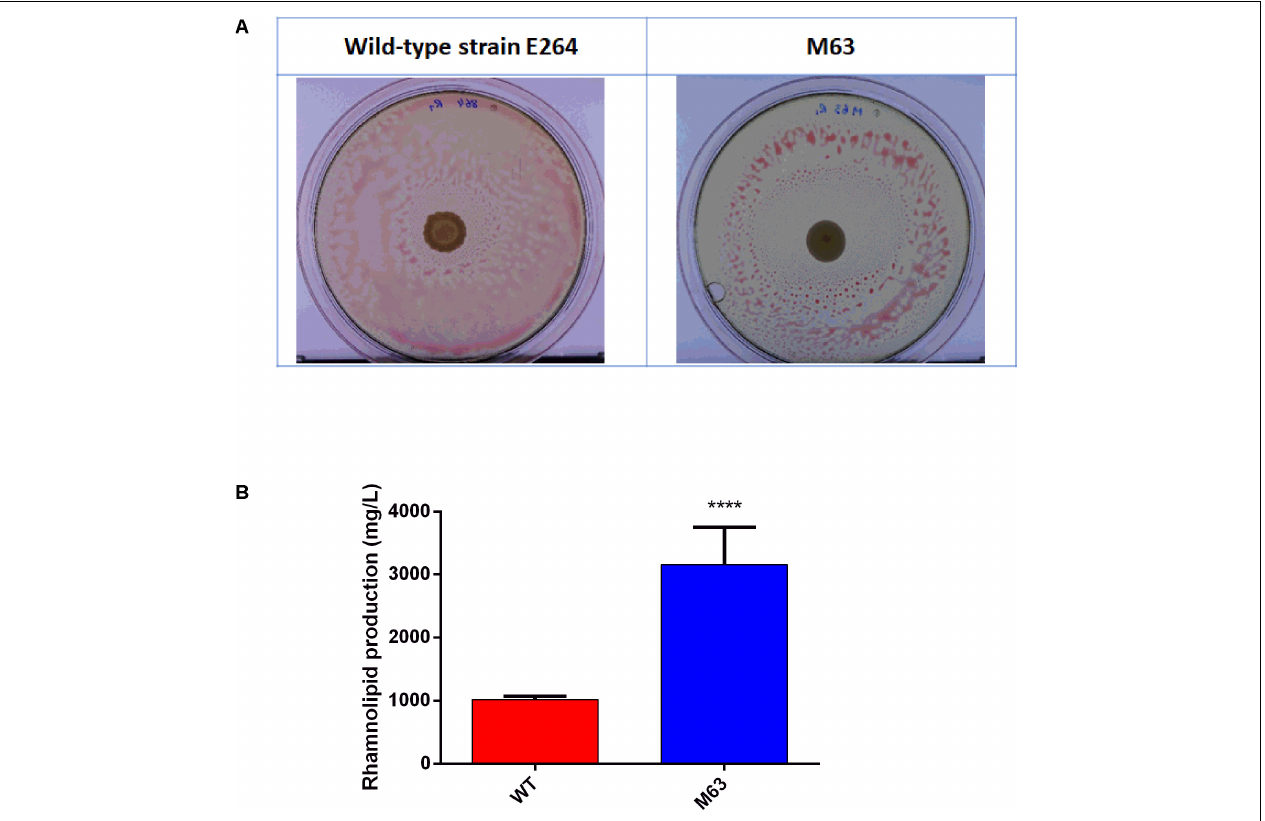
FIGURE 1 | Random mutagenesis identifies a rhamnolipid overproducer of B. thailandensis E264. (A) Phenotypic selection by oil spraying, (B) Rhamnolipid quantification after 5 days of culture in NB + 2% glycerol. The error bars represent standard deviation from the mean ( n = 3 independent cultures). Asterisk indicates statistically significant differences (* p < 0.05) in paired Student’s t